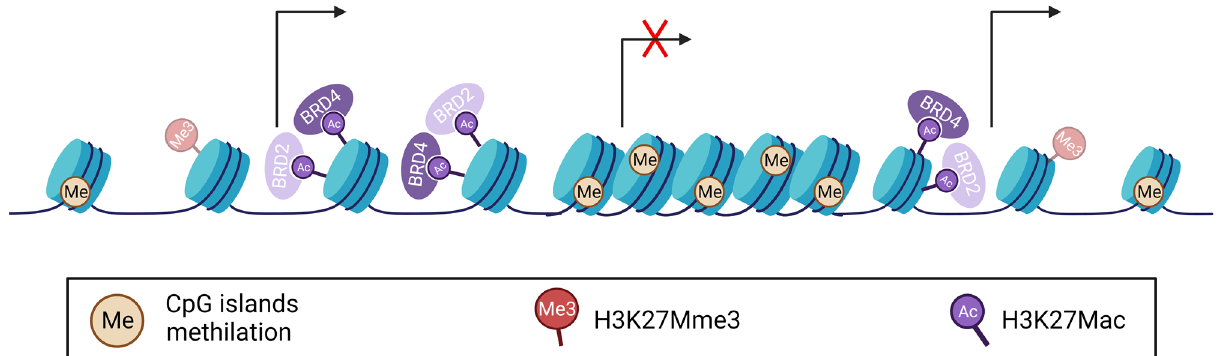
Figure 2. GBM Epigenome. H3K27M mutation results in global genomic decrease in H3 trimethylation (H3K27Mme3) and a concomitant increase in H3 acetylation (H3K27Mac), coupled to enhanced BRD2 and BRD4 recruitment and aberrant induction of gene expression. Tumor-suppressors hypermethylation also occurs.